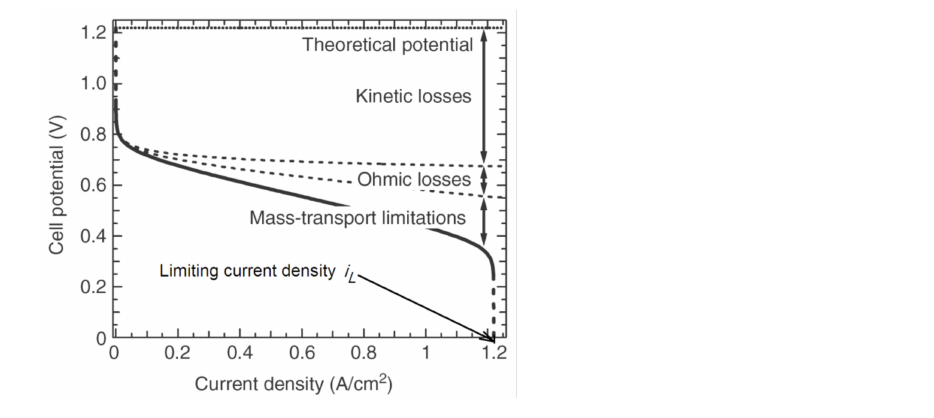
Figure 6. PEM-FC’s polarization curve showing the limiting current density ( i L ) and the various potential losses.